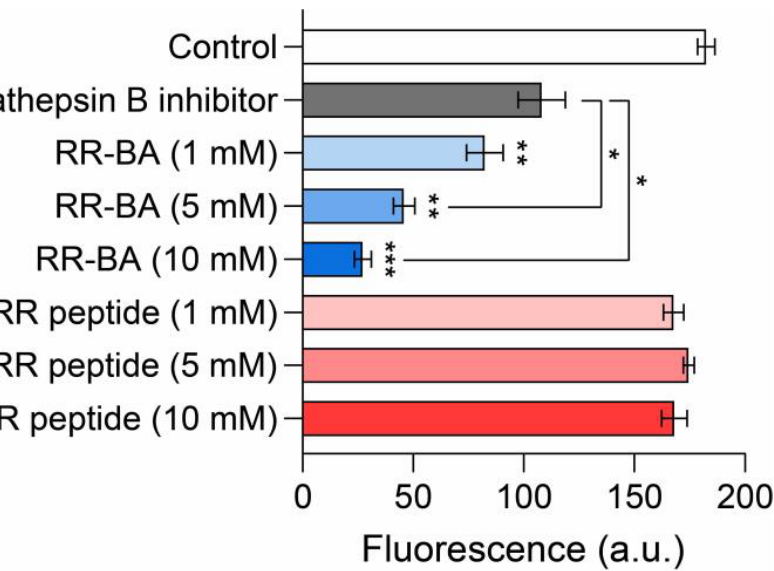
Figure 5. Cathepsin B expression level analysis. Cathepsin B activity was measured in CT26 cells that were treated with the control (Ac-RR-AFC), cathepsin B inhibitor (from the cathepsin B activity assay kit) as a positive control, or various concentrations of RR peptide and RR–BA for 2 h. The cathepsin B enzymatic activity is presented in fluorescence units (a.u.). * p < 0.05, ** p < 0.01, *** p < 0.001. Results represent means ± S.D.